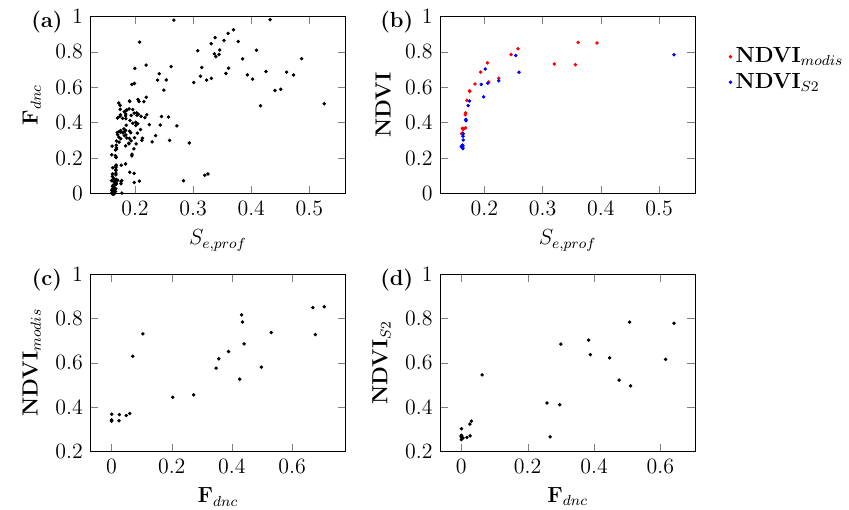
Figure 7. Scatter plots of ( a ) community level normalized sap flow (F dnc ) versus S prof (dimensionless), ( b ) NDVI modis and NDVI S 2 versus S prof , ( c ) NDVI modis versus F dnc , ( d ) NDVI S 2 versus F dnc